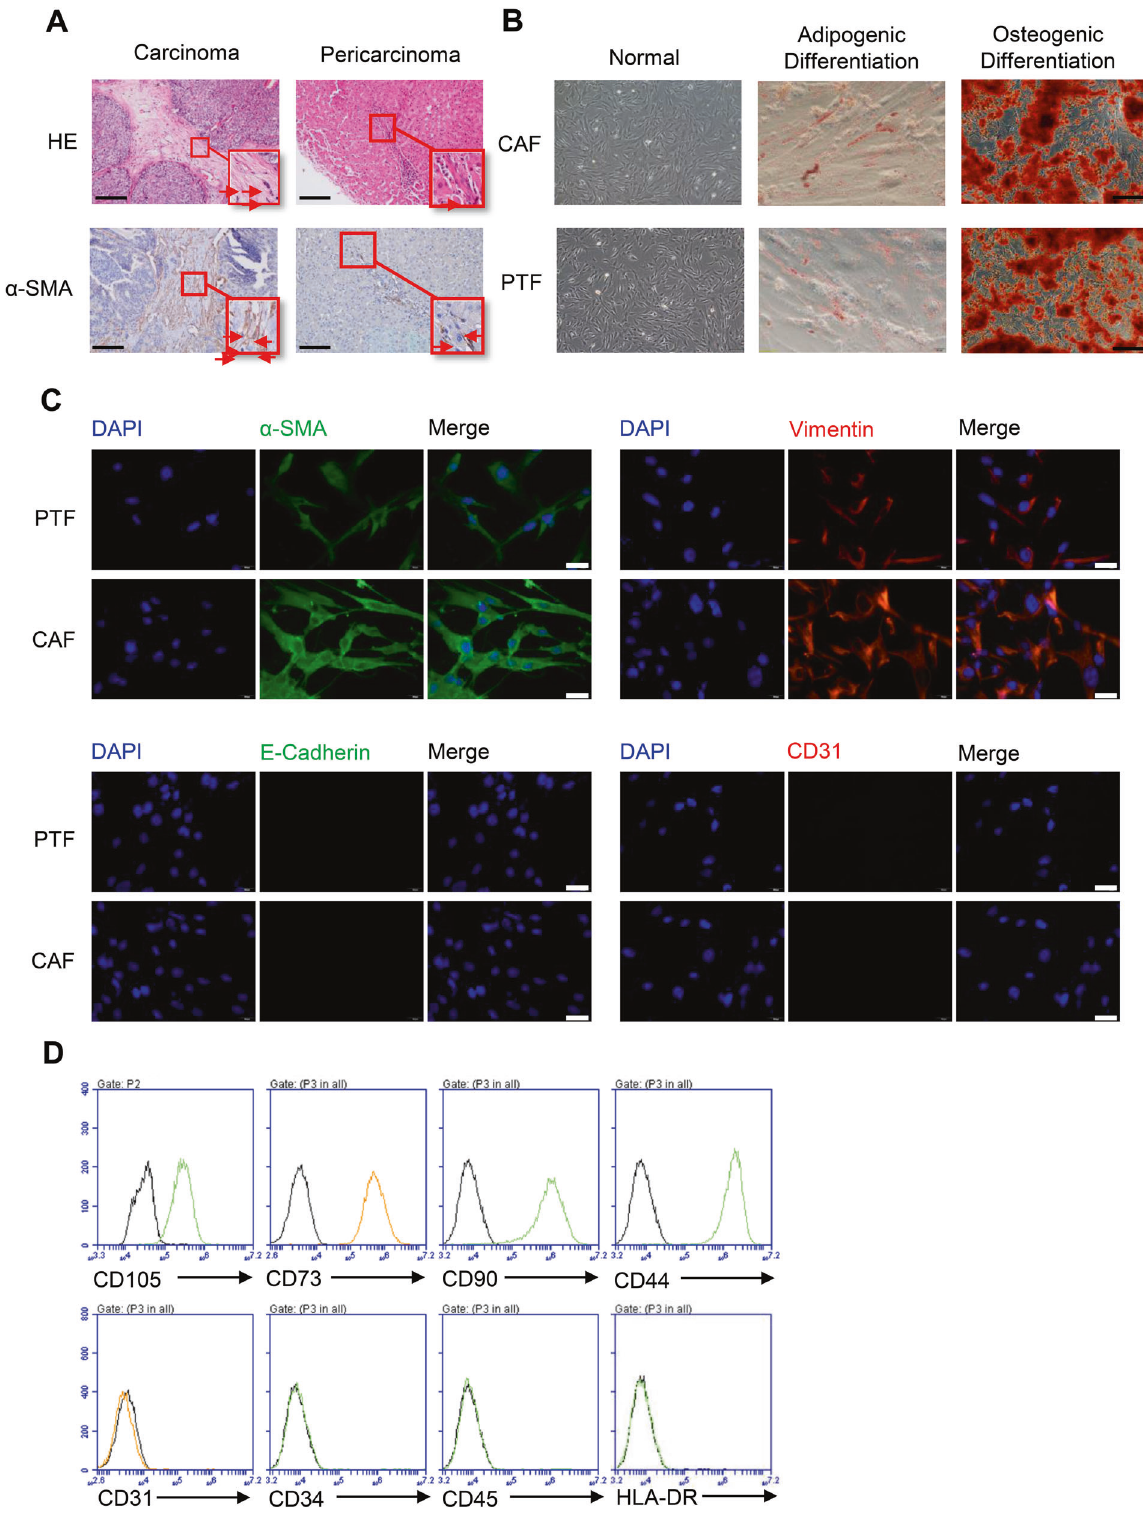
Fig. 1 Identi fi cation and differentiation potential of CAFs isolated from HCC tissues. A HCC tissues and matching tumor-adjacent tissues were subjected to H&E staining respectively (upper); IHC images showed α -SMA expression respectively (lower). The red arrows indicated α - SMA positive cells. Scale bar: 100 μ m. B The images showed representative morphology of CAFs and PTFs in vitro. The isolated CAFs and PTFs were treated with adipogenic induction and stained by Oil Red O. And CAFs and PTFs were treated with osteogenic induction and stained by Alizarin Red S. Scale bar: 100 μ m. C Immuno fl uorescence staining of CAFs and PTFs showed α -SMA, Vimentin positive expression and E- cadherin, CD31 negative expression. Scale bar: 100 μ m. D Flow cytometric analysis showed CAFs were positive for CD105, CD73, CD90, and CD44, negative for CD31, CD34, CD45, and HLA-DR.